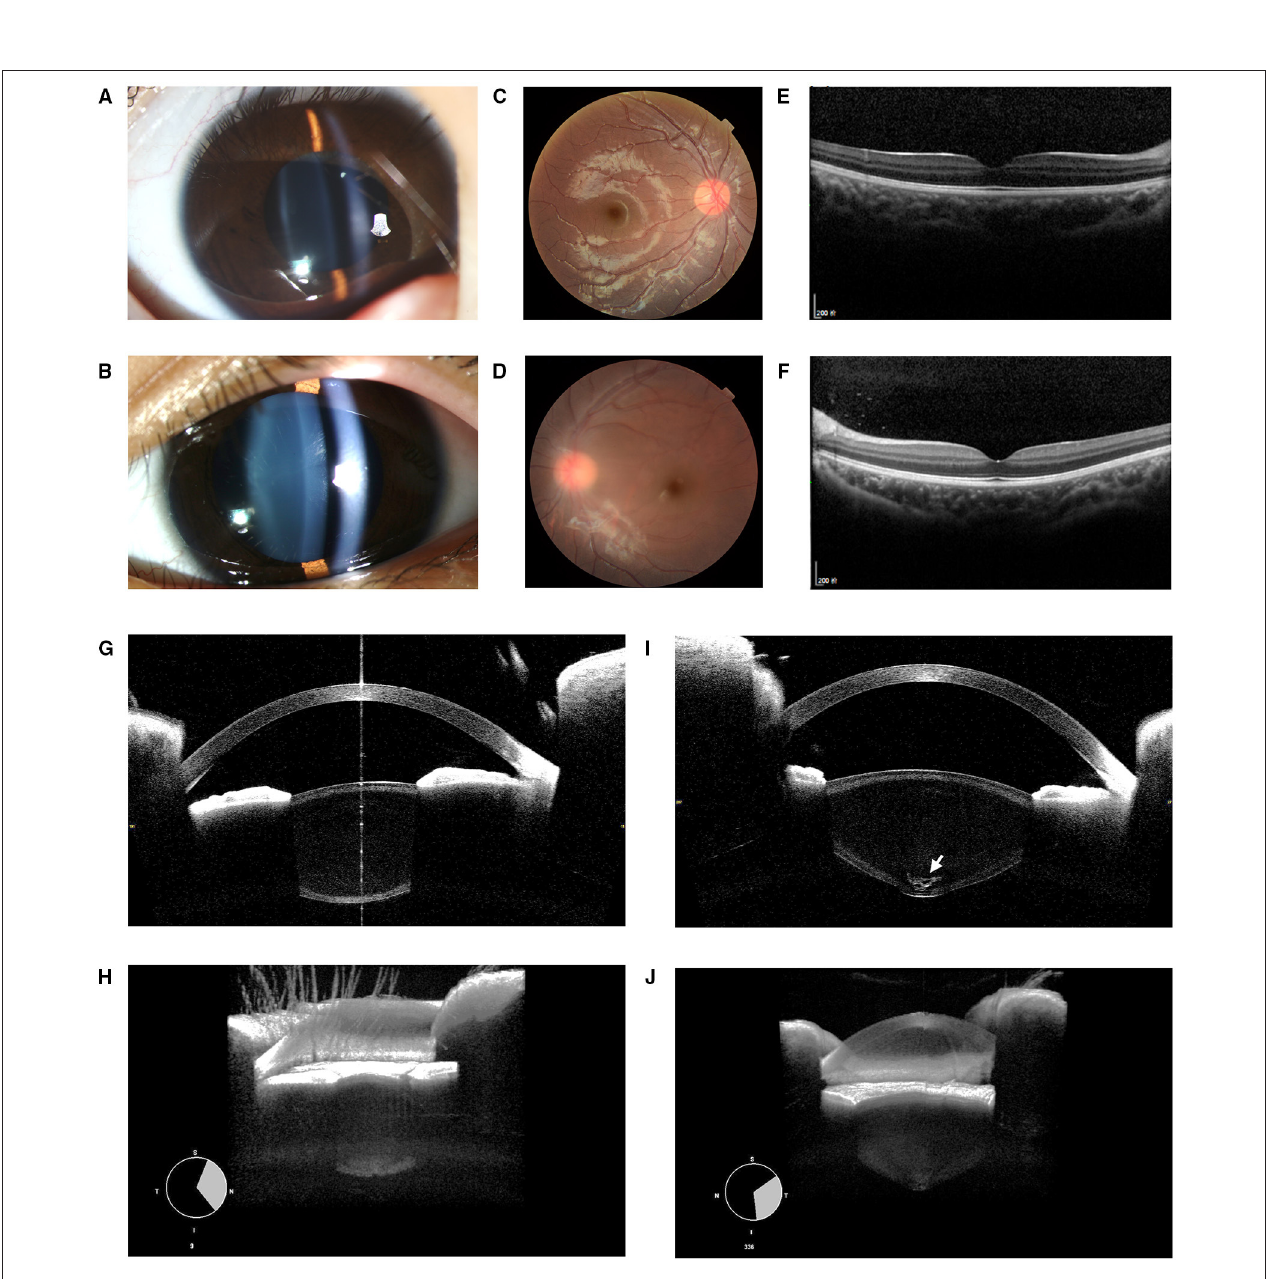
FIGURE 3 | Ocular images of Patient 3 with posterior lenticonus (PL). (A) A slit-lamp photograph showed a normal lens in the right eye. (B) The light beam showed a cone-shaped protrusion of the posterior lens surface in the left eye with no apparent posterior polar cataract. (C–F) Abnormities of fundi were found in either eyes. (G) Normal lens image obtained by CASIA2. (I) The PL associated with posterior polar cataract (indicated by an “arrow”) of OS was found. (H) 3D reconstructed images showed the normal anterior segment in the right eye. (J) A cone-shaped protrusion of the posterior lens was reconstructed in the left eye.